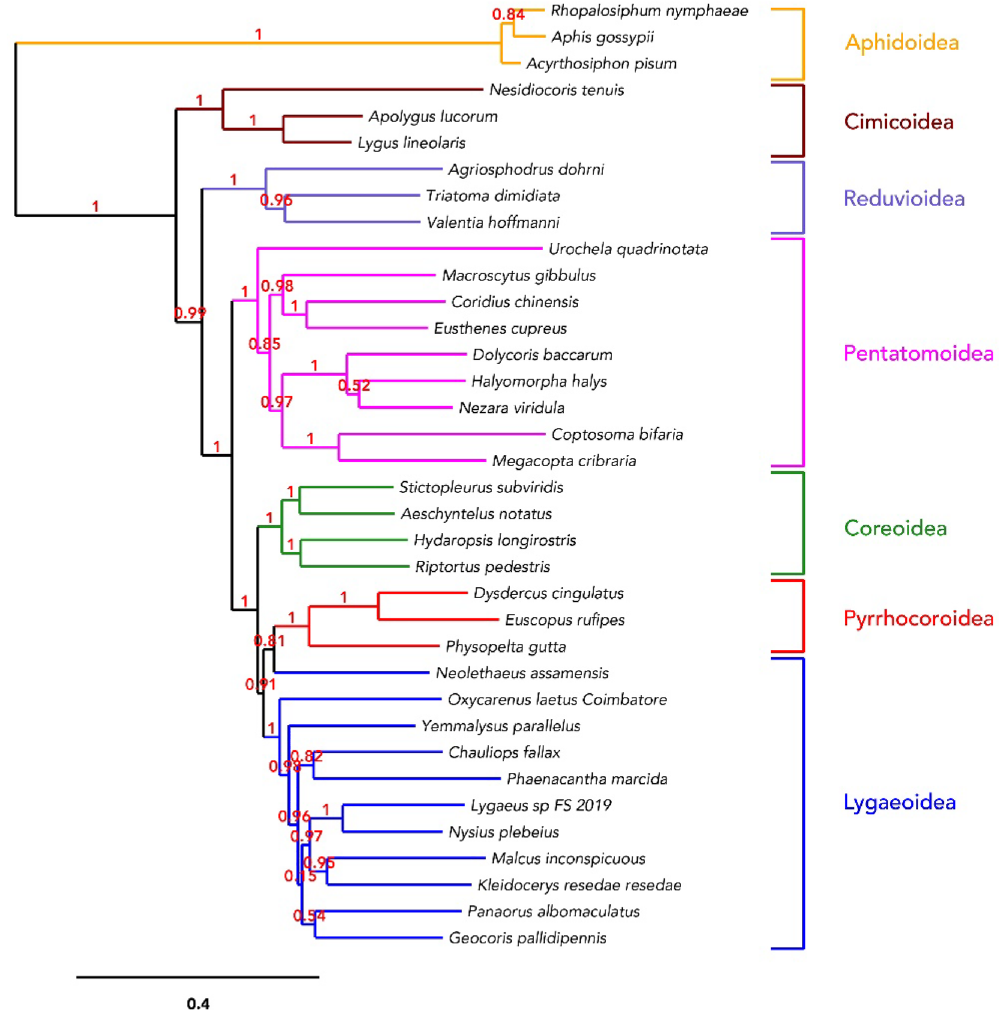
Figure 3. Phylogenetic relationship inferred among 36 whole mitochondrial genomes from seven different super-families of Hemiptera. The above tree shows O. laetus and other member species are clustered under their respective